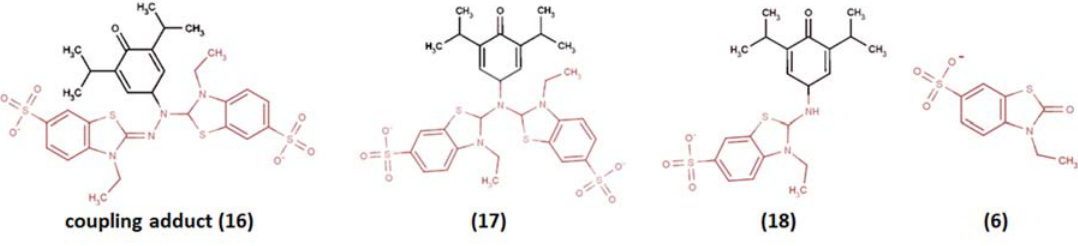
Figure 8. The proposed structures of ABTS • + with propofol reaction products [128].